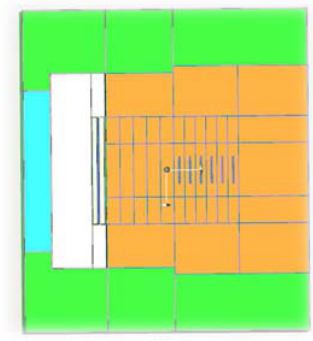
Figure 2. The geometry model built in